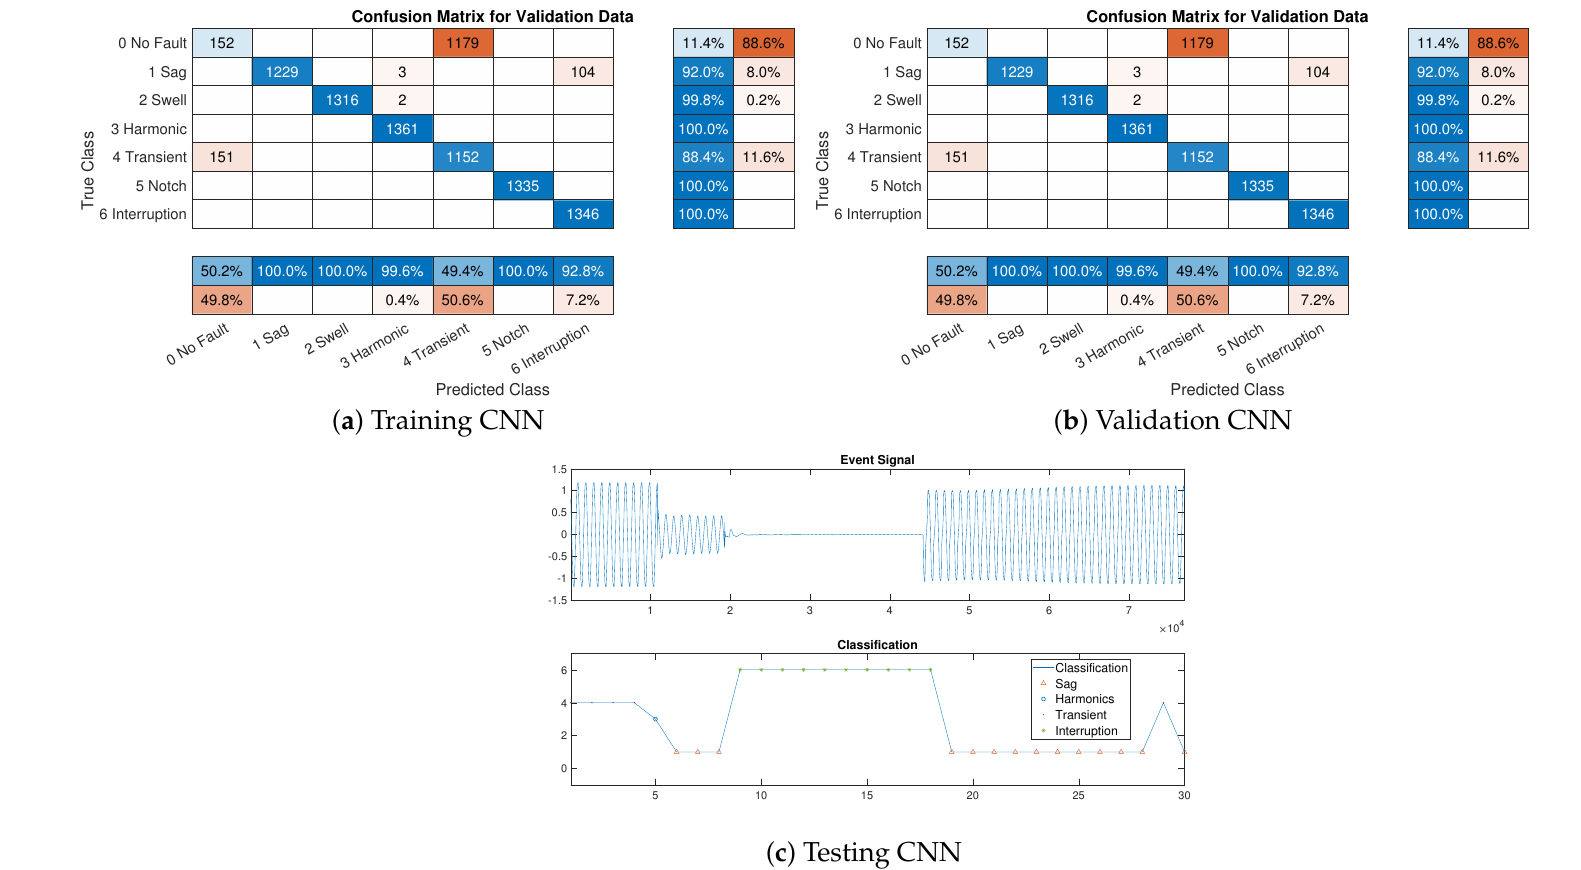
Figure 10. ( a ) Confusion matrix of the CNN training, ( b ) Confusion matrix of the CNN validation, ( c ) Testing of the CNN using a simulated voltage waveform.